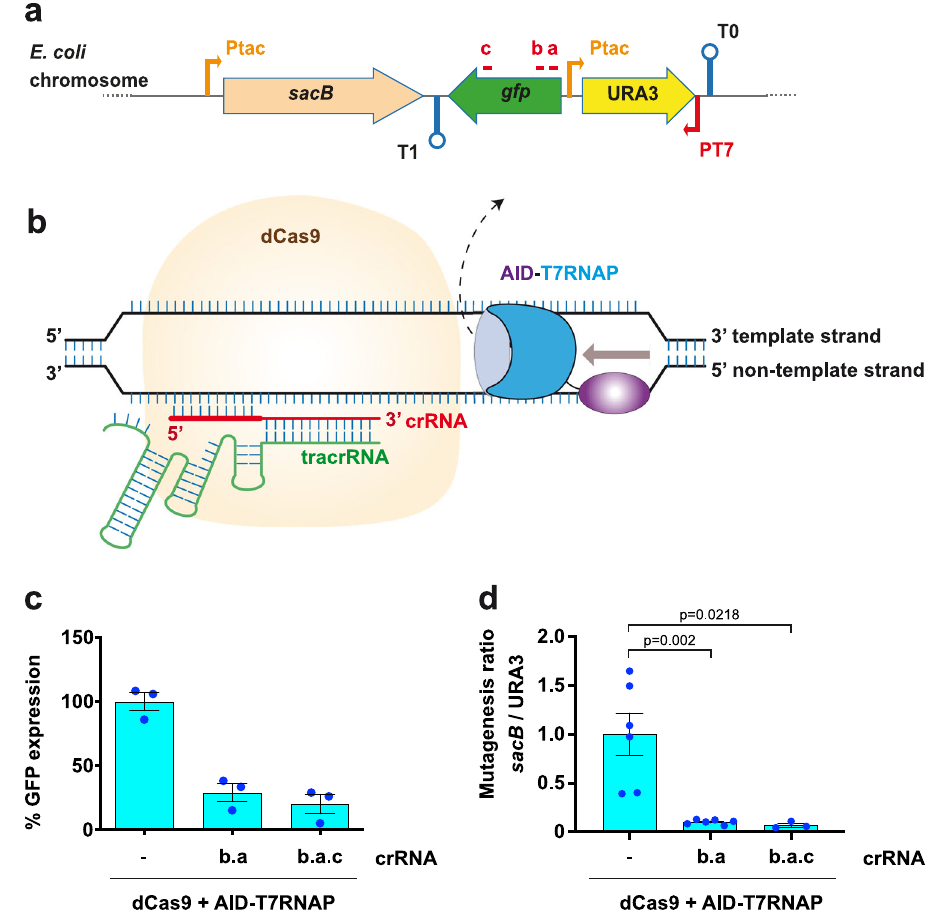
Fig. 5 Blocking AID-T7RNAP elongation and mutagenic activity by dCas9 and crRNAs. a Scheme of the reporter cassette with sacB integrated in MG*- SacB-URA3 Δ ung Δ n fi strain. Thin arrows indicate the tac (P tac ) and T7 (P T7 ) promoters, lollipops indicate terminators T0 and T1; red lines mark targeting sequences of the crRNAs a, b, and c; fi lled arrows indicate the genes sacB (orange), gfp (green), and URA3 (yellow). b Representation of the dCas9 blocking activity showing one crRNA (in red) targeting the non-template strand relative to T7RNAP transcription. The direction of the progession of the fusion along the DNA is indicated with a gray arrow. The mutagenic protein fusion (AID-T7RNAP) is displaced from the transcription bubble (dashed arrow) by bound dCas9/crRNA. The orange shape represents the dCas9, the blue shape joined by a black line to a purple elliptical shape represents the fusion AID- T7RNAP, the red RNA molecule represents the crRNA and the green RNA molecule represents the tracrRNA. c Relative GFP levels measured by fl ow cytometry of bacteria from strain MG*-SacB-URA3 Δ ung Δ n fi expressing AID-T7RNAP and dCas9 in the absence ( − ) or presence of crRNA arrays b.a and b.a.c. The histogram shows the percentages of mean fl urorescence intensities (MFI) for each condition relative to the strain lacking crRNAs. Background GFP fl uorescence signals from this strain with pdCas9 and the empty vector pSEVA221 are subtracted from all values ( n = 3 independent experiments). d Ratio of mutagenesis of sacB vs. URA3 in bacteria MG*-SacB-URA3 Δ ung Δ n fi expressing AID-T7RNAP and dCas9 in the absence ( − ) or presence of crRNA arrays b.a and b.a.c. The ratio found in bacteria lacking crRNAs are considered 1 (control n = 6, b.a n = 6, b.a.c n = 3). For c and d , the histograms represent the single values (blue dots), the relative means (bars), and standard errors (black lines) from multiple independent experiments. The statistical analysis was done using two-tailed Student t test. Exact p values ( p ) are indicated in the fi gure. A p value < 0.05 was considered signi fi cant. Source data are provided as a Source data fi